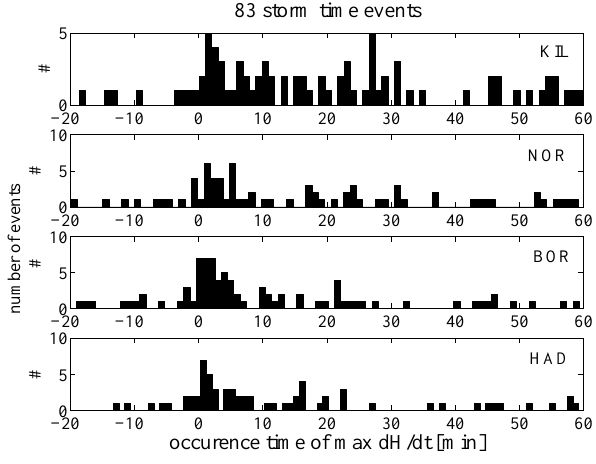
Fig. 3. Times at which max | d H /dt | occurs at SAMNET stations, KIL (Kilpisjarvi, 65.9 ◦ N), NOR (Nordii, 61.5 ◦ N), BOR (Borok, 54.11 ◦ N), HAD (Hartland, 50.99 ◦ N), during non-storm time. Sub- storm onset occurs at 0min. CGM latitudes.